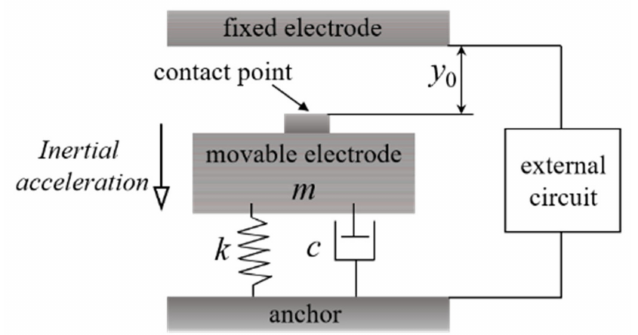
Figure 1. Schematic diagram of the spring ( k )–mass (movable electrode m )-damping ( c ) system model of a uniaxial inertial switch. y 0 means the initial distance between the movable electrode and the fixed